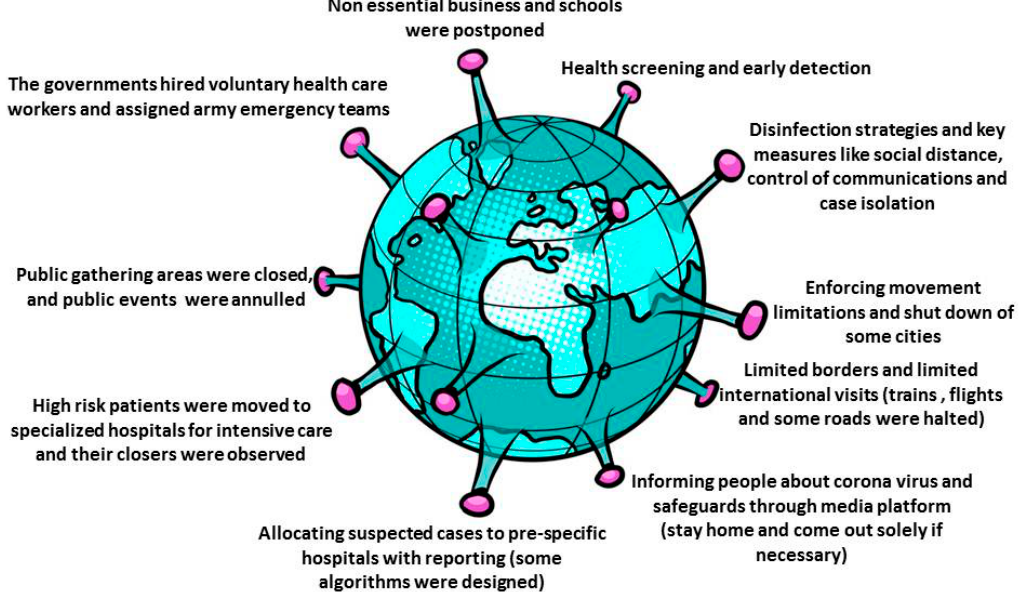
Figure 4. Common governmental responses to